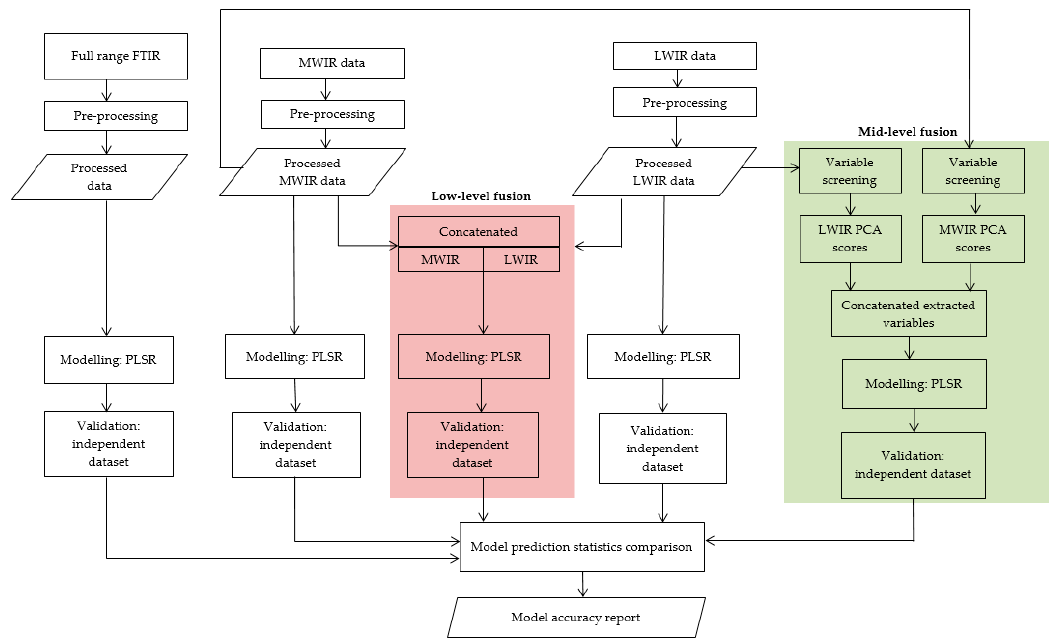
Figure 2. A workflow diagram depicting the steps of the research approach.